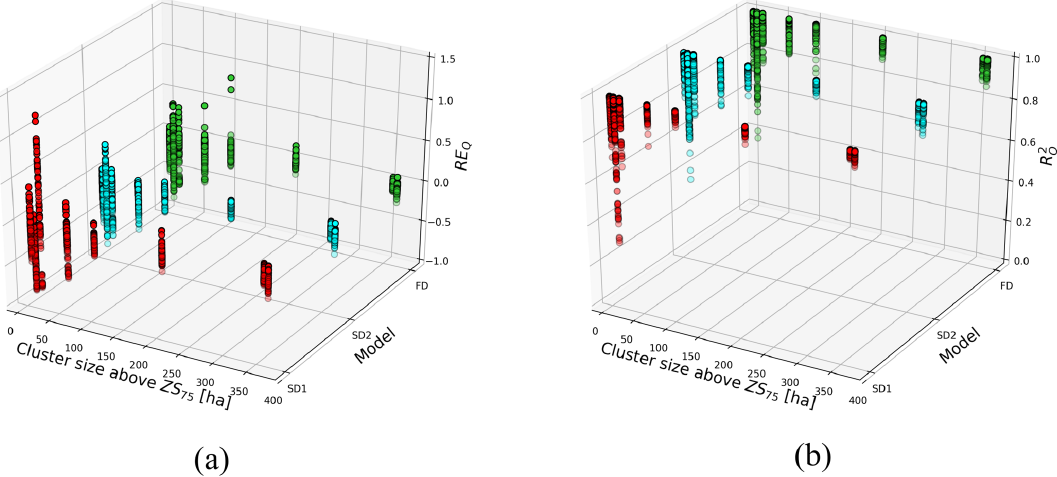
Figure 8. Re Q and R 2 variability, in relation to model type and rainfall characterized by cluster dimension S Z 75 , for all locations and all Q combinations of rainfall input resolution. Colours identify the three different models.